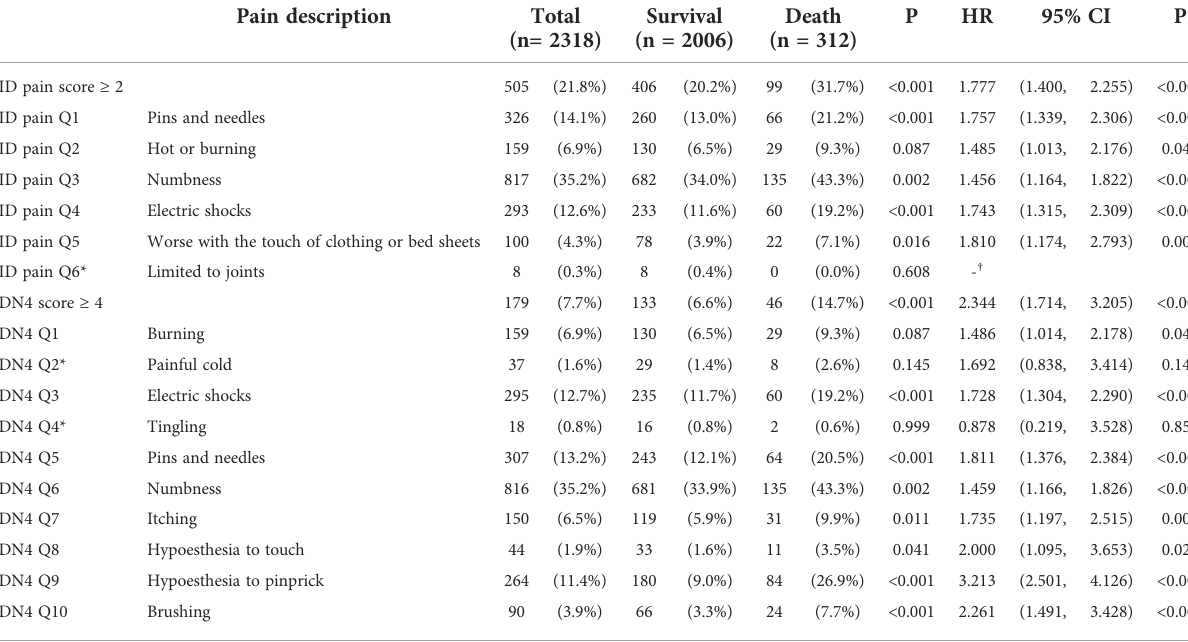
TABLE 2 The number (percentage) and mortality HR (95% CI) of patients with positive symptoms for each question item.